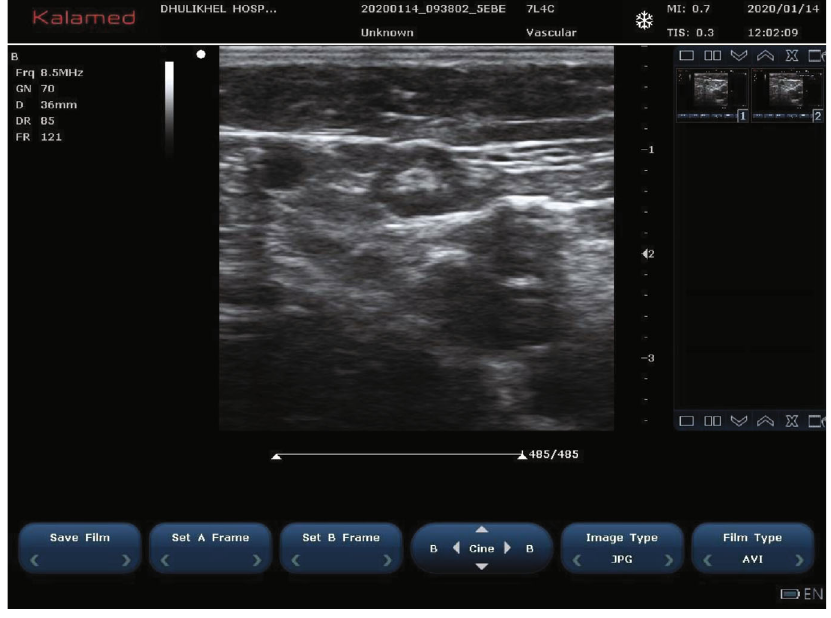
Figure 10: Triangle made by the GSV, lymph node, and deep veins.